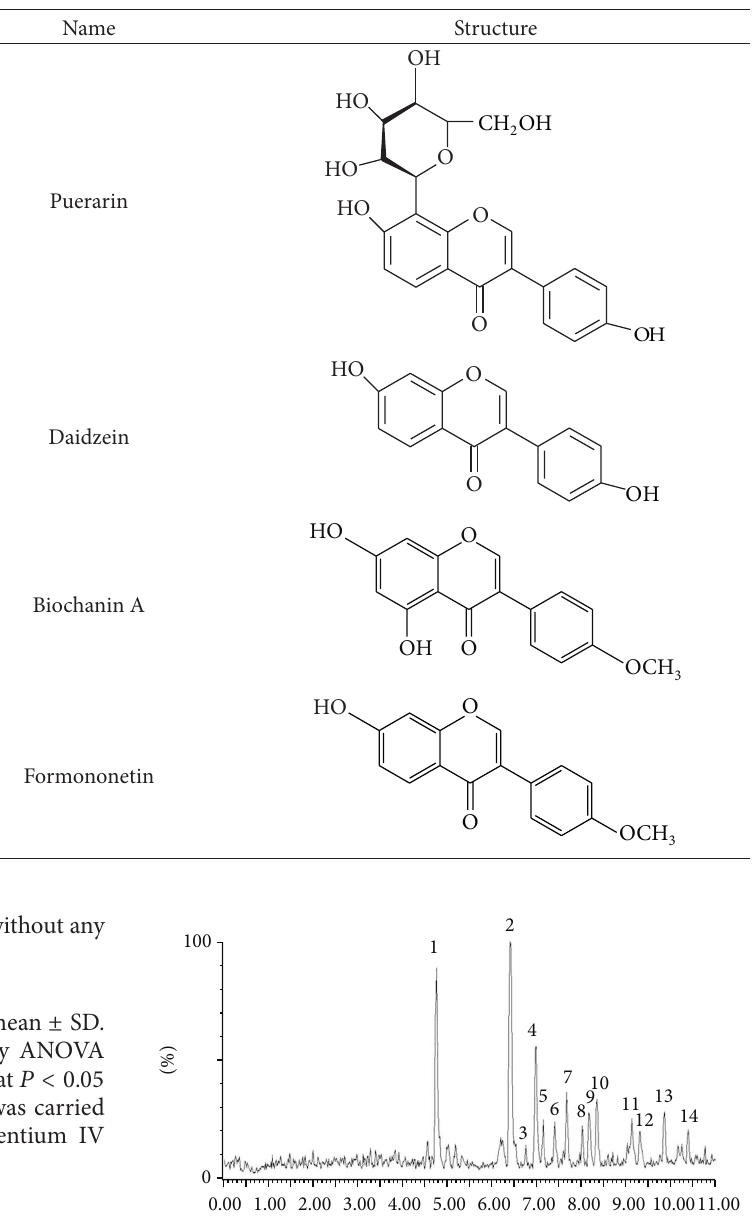
Table 1: The structure of compounds identified in Pueraria tuberosa by LC-MS.